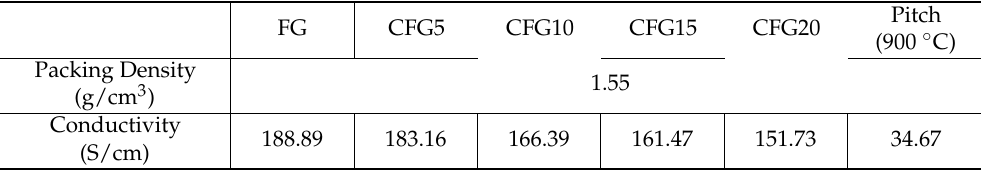
Table 3. Electronic conductivity at a packing density of